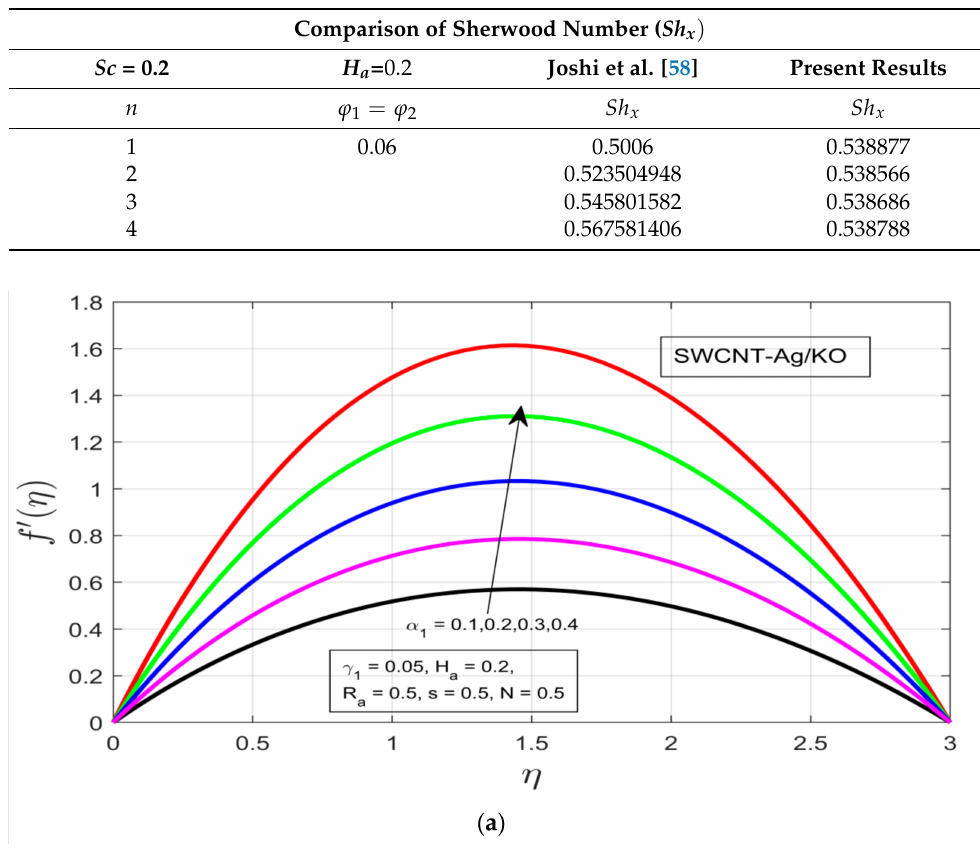
Table 5. Comparison of obtained outcomes with previously published work.